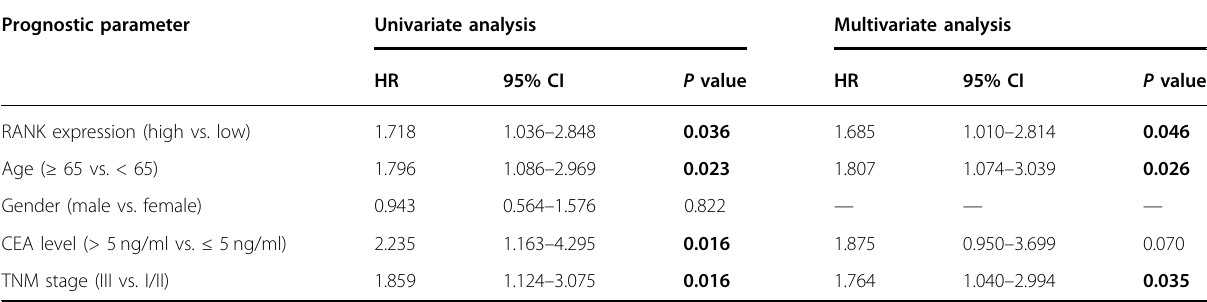
Table 3 Univariate and multivariate analyses of recurrent factors for disease-free survival in 173 CRC patients (stages